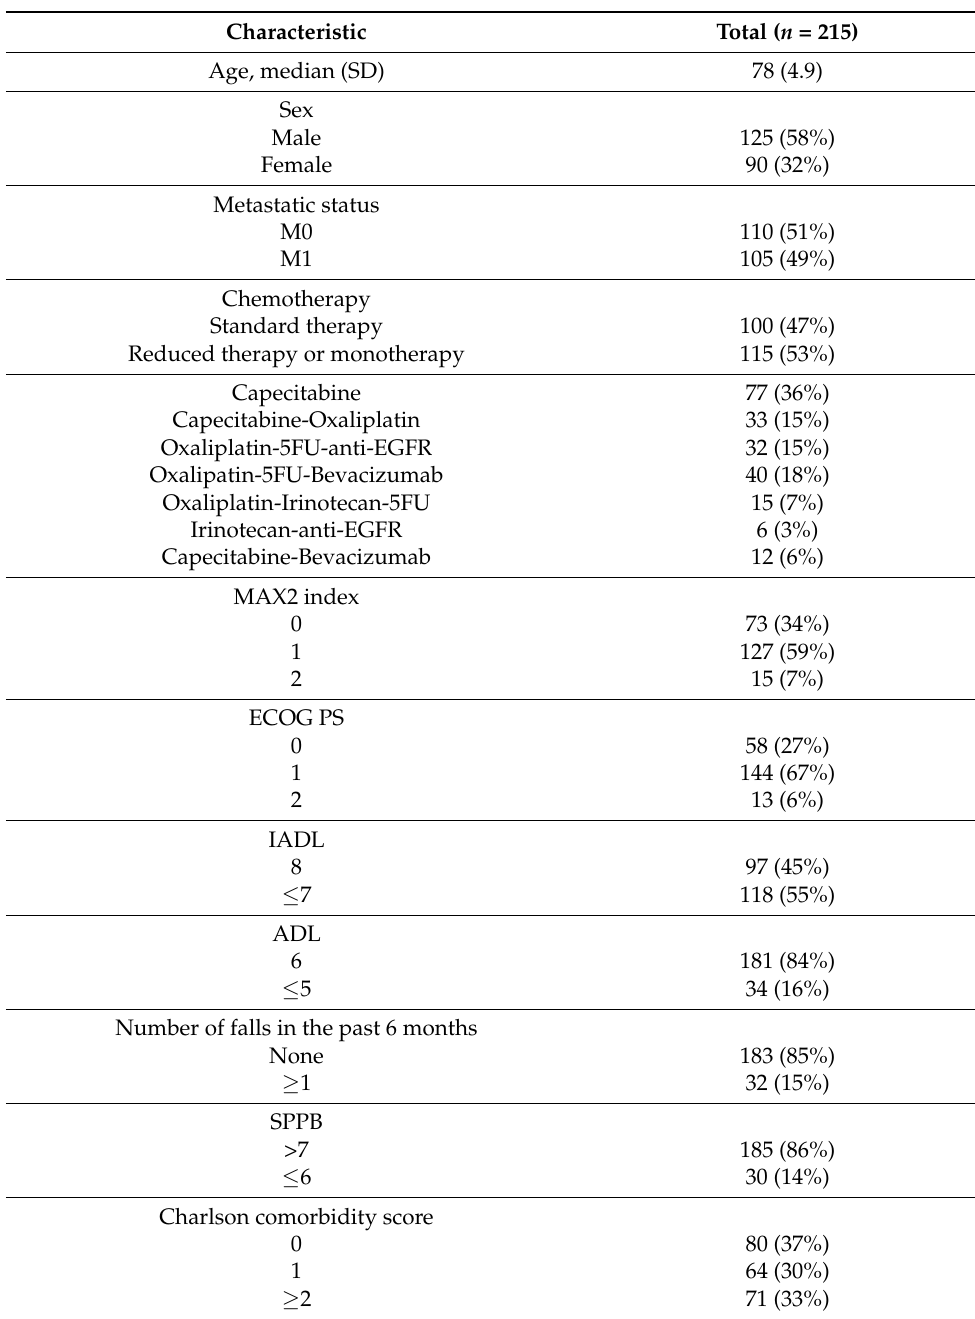
Table 1. Patient